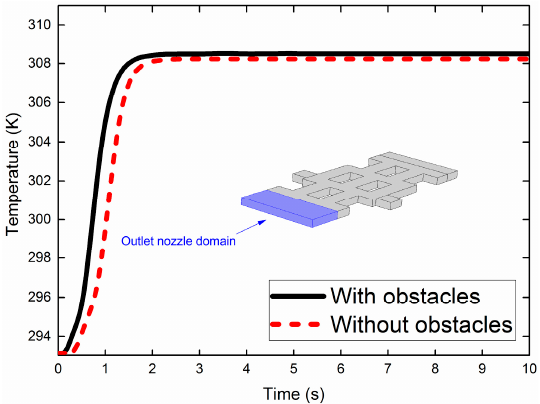
snapshots were taken from the system every 2.0 s over the total simulation runtime of 10.0 s in which the mixing chamber was fully filled with blood and plasma.